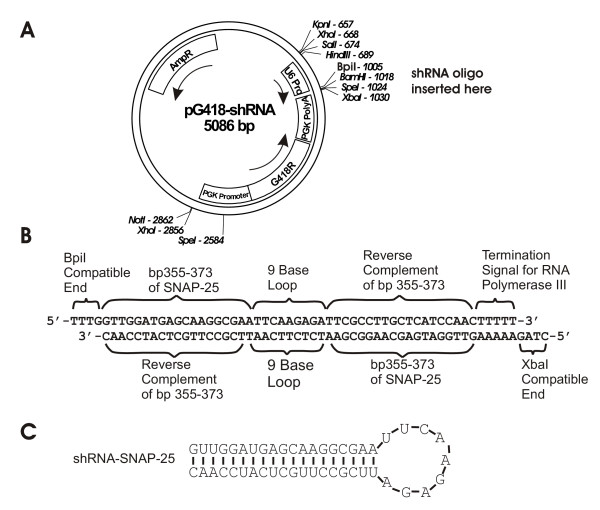
Plasmid-based expression of shRNA-SNAP-25. A) Plasmid map of pG418-shRNA, a plasmid designed to express shRNAs from the mouse U6 promoter. B) The two 56-base deoxyoligonucleotides used in the construction of pG418-shRNA-SNAP-25 are shown as they would be paired after annealing. The labels above and below the oligonucleotides indicate the source or the function of the nucleotides in the indicated regions. C) The predicted stem-loop structure of shRNA-SNAP-25 expressed from pG418-shRNA-SNAP-25.